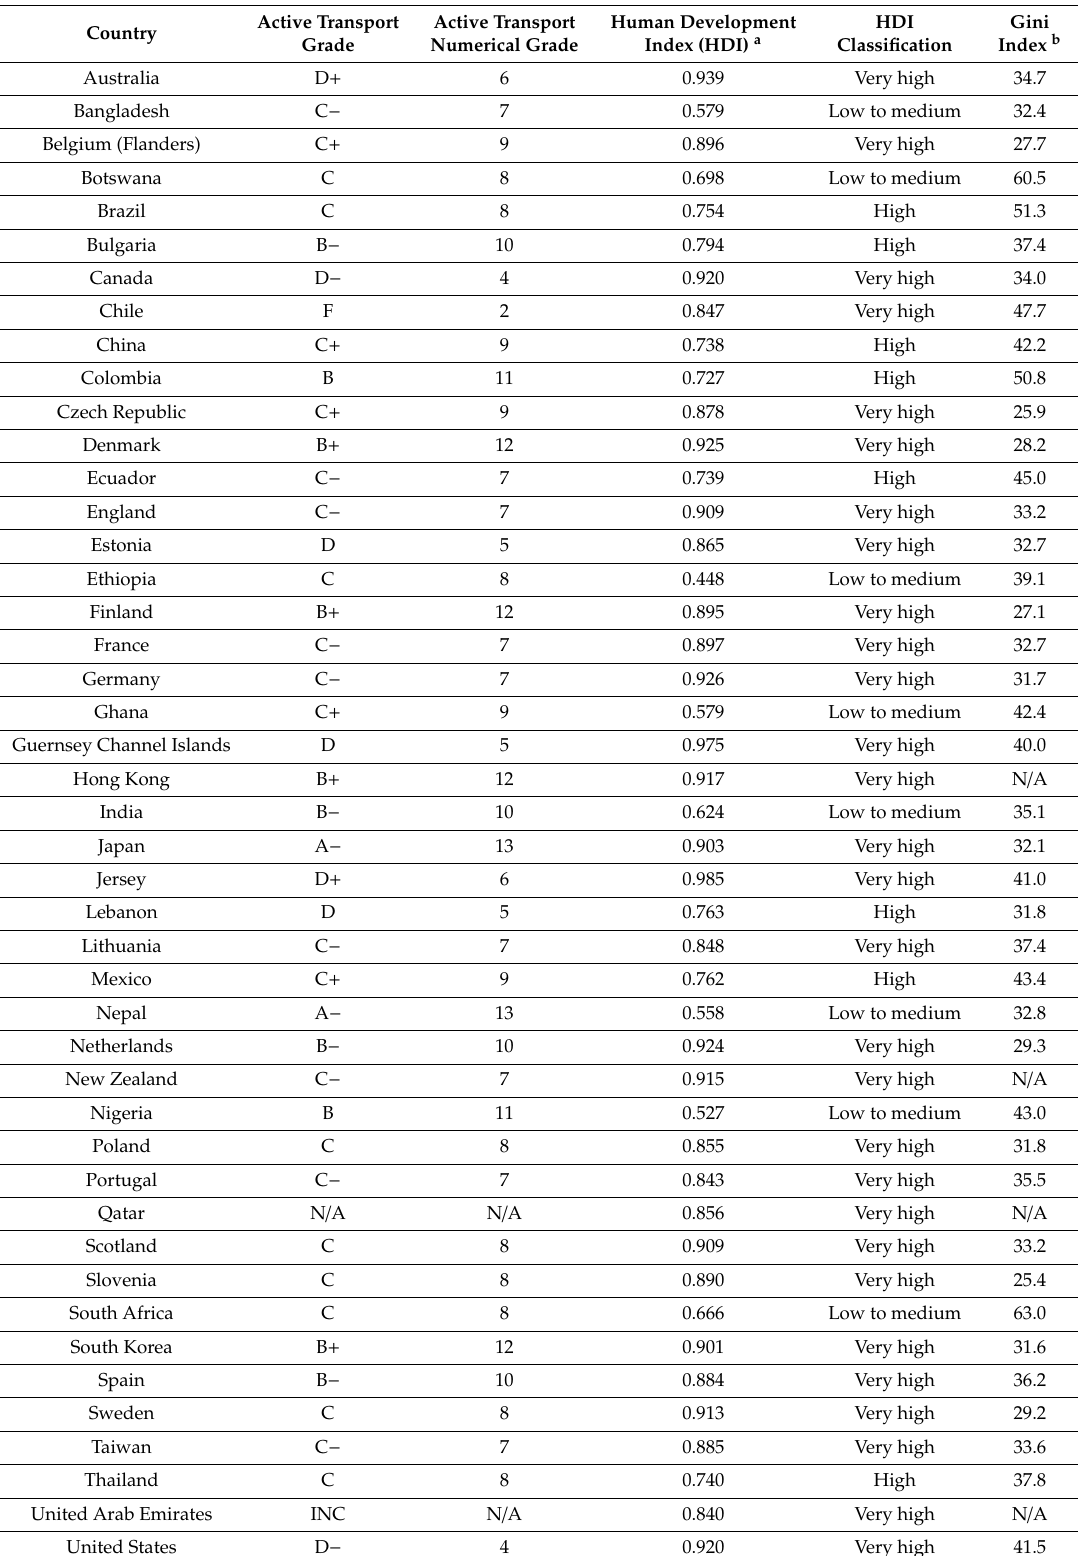
Table 2. Active transportation grades and sociodemographic variables of the 49 countries participating in the Global Matrix